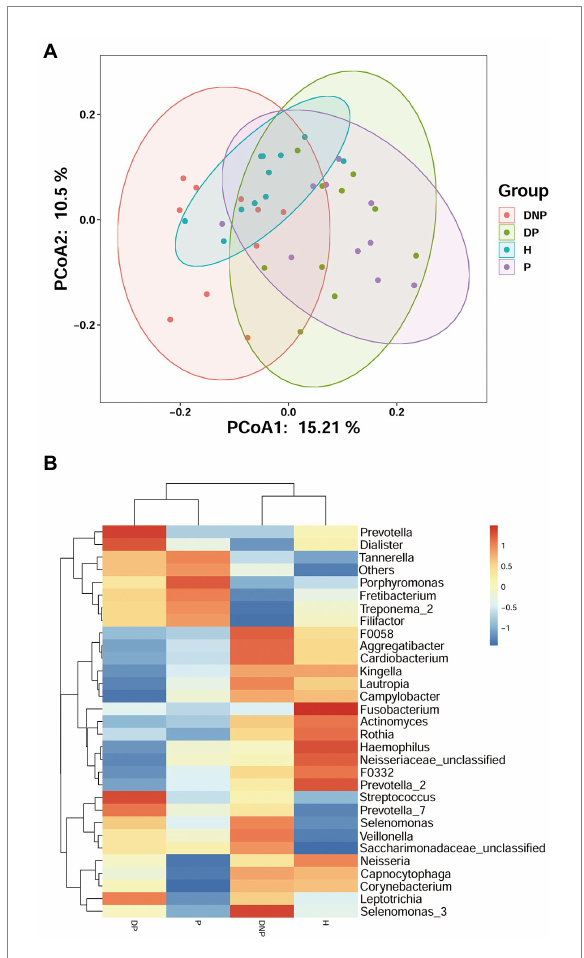
FIGURE 1 Distribution of differential genera among four groups. (A) Principal Co-ordinates Analysis of bacterial communities in different groups. Each symbol represents one sample; Each color represents one group. (B) The subgingival microbial compositions profiles of four groups at the genus level. The abundance of different subgingival genera in different group. Blue represents lower abundance, and red represents higher